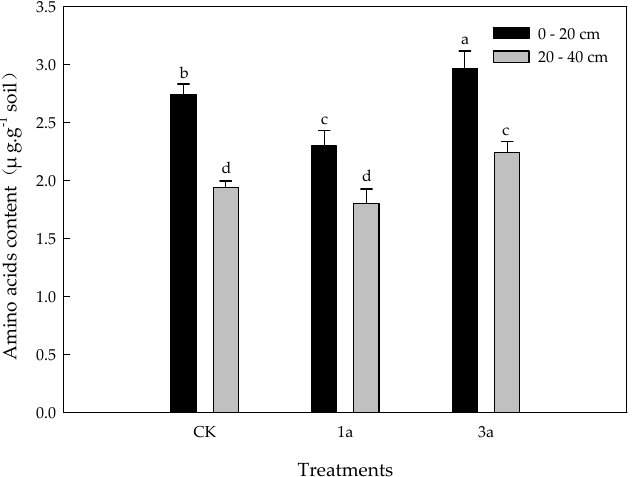
Figure 3. Effects of returning shoots on the soil amino acids content. CK: control; 1a: shoots returned for 1 year; 3a: shoots returned for 3 years. Different lowercase letters in the same figure indicate significant differences at the 0.05 level.